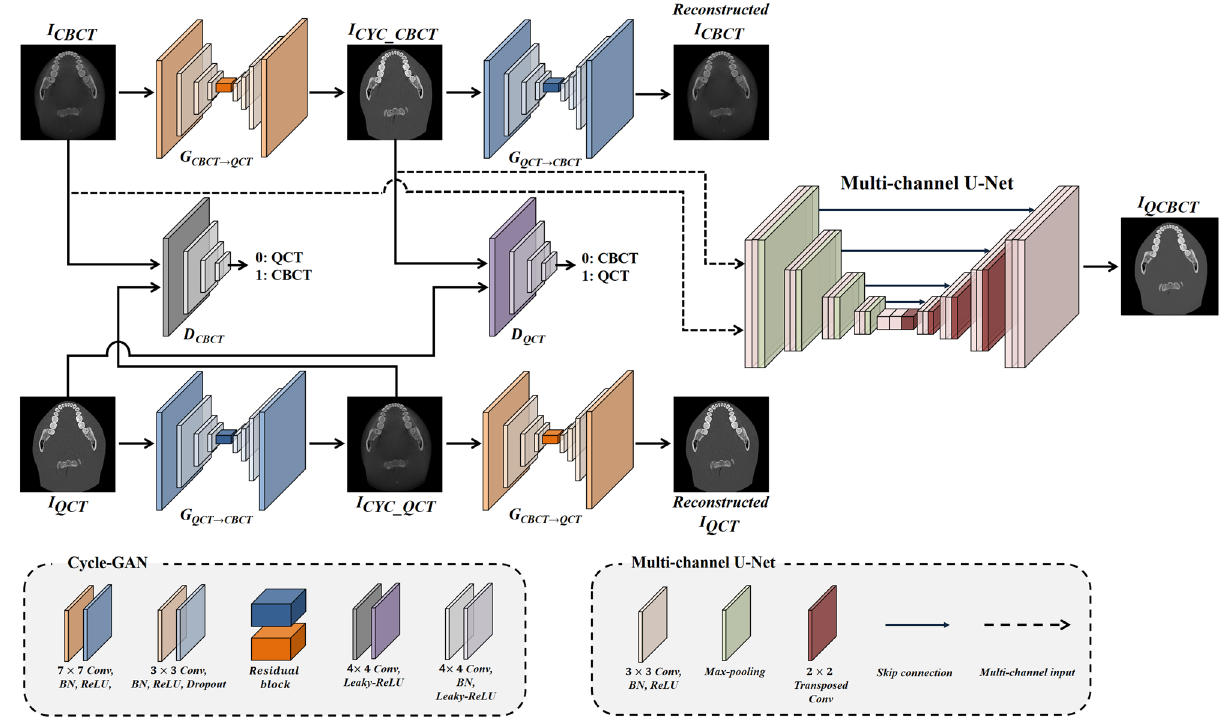
Figure 2. The QCBCT-NET architecture combining Cycle-GAN and the multi-channel U-net. The Cycle- GAN consisted of two generators of G CBCT → QCT , and G QCT → CBCT , and two discriminators of D CBCT , and D QCT . In the generators, the convolution block consisted of 7 × 7 and 3 × 3 convolution layers with batch normalization and ReLU activation, and residual blocks were embedded in the middle of the down-sampling and up-sampling layers. In discriminators, the convolution block consisted of 4 × 4 convolution layers with batch batch normalization and ReLU activation, and had skip connections at each layer level. Max-pooling was used for down-sampling and transposed convolution was used for up-sampling. Consequently, the QCBCT-NET generated QCBCT images from CBCT images to quantitatively measure BMD in